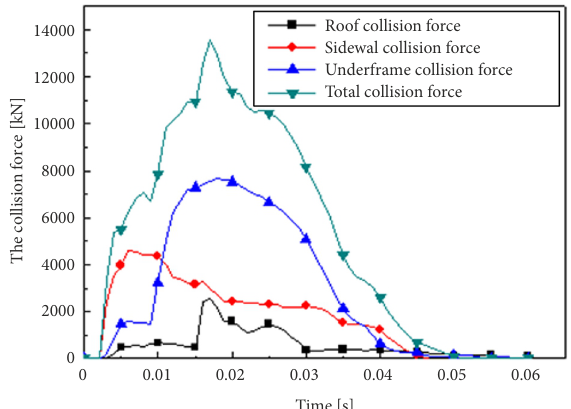
Figure 19. Transfer characteristic curve of the collision force